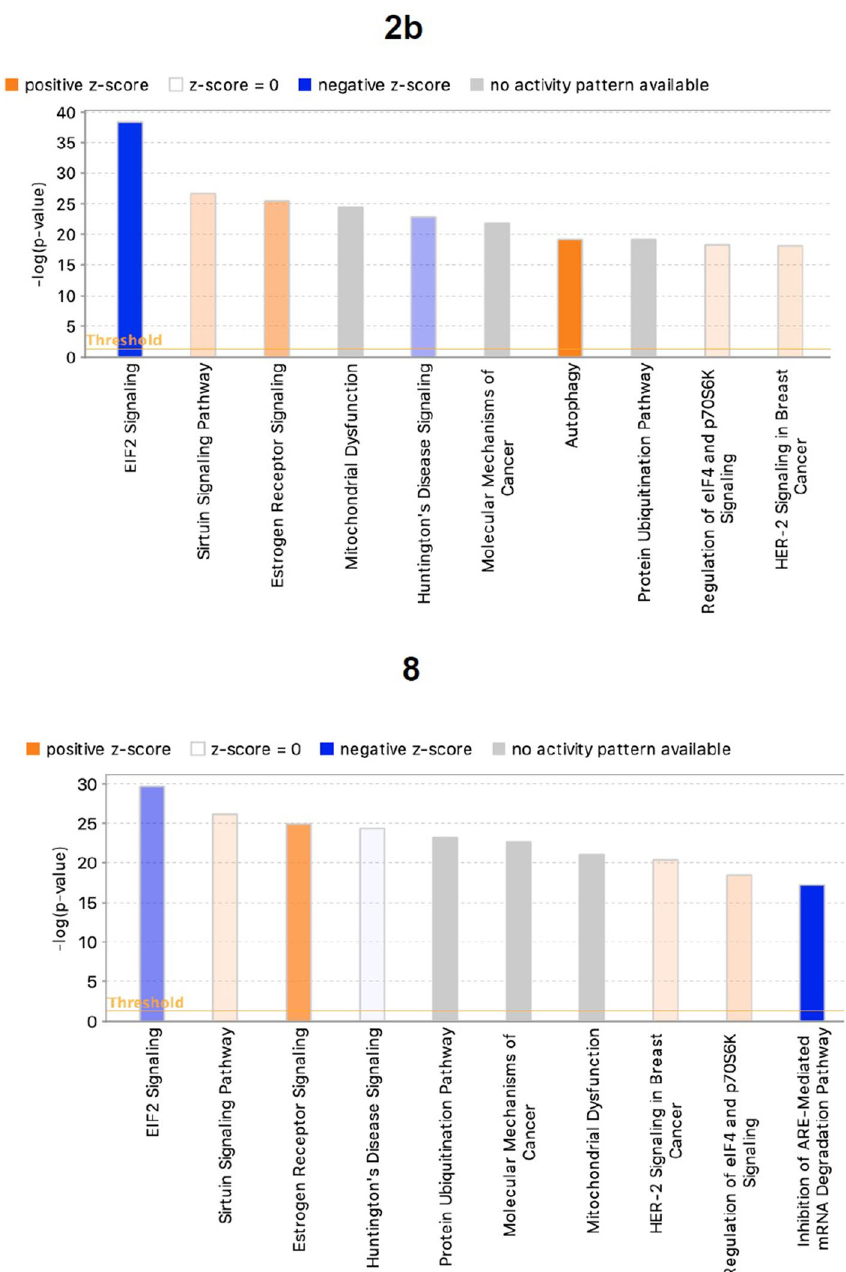
Figure 7. Human gene pathways significantly altered by 2b and 8 . Differentially Expressed Genes (DEG) measured by comparing 2b - and 8 -treated NPCs vs. vehicle-treated NPCs were subjected to Ingenuity Pathway Analysis (IPA). The top 10 pathways showing the greatest statistical significance (Fisher’s Exact Test p-value) are shown. Activation (+ve z-score, orange bars) or inhibition (−ve z-score, blue bars) of each pathway is a measure of experimentally determined gene expression changes reported in the literature. The intensity of color indicates the degree of activation/inhibition. Pathways without an activity pattern are in grey. Ratios (orange square above each pathway) represent the degree of overlap between DEG and all members of a given pathway. Y-axis on the right indicates ratio